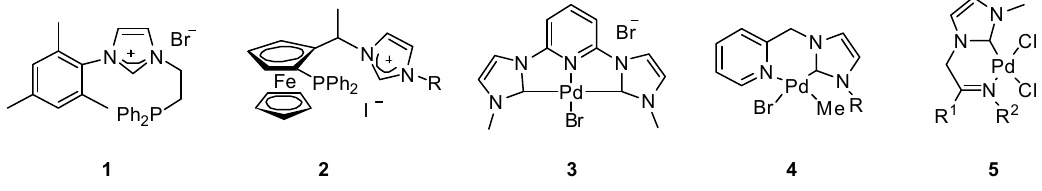
Figure 1. Typical Pd-NHC complexes and NHC precursors with a (potentially) coordinative